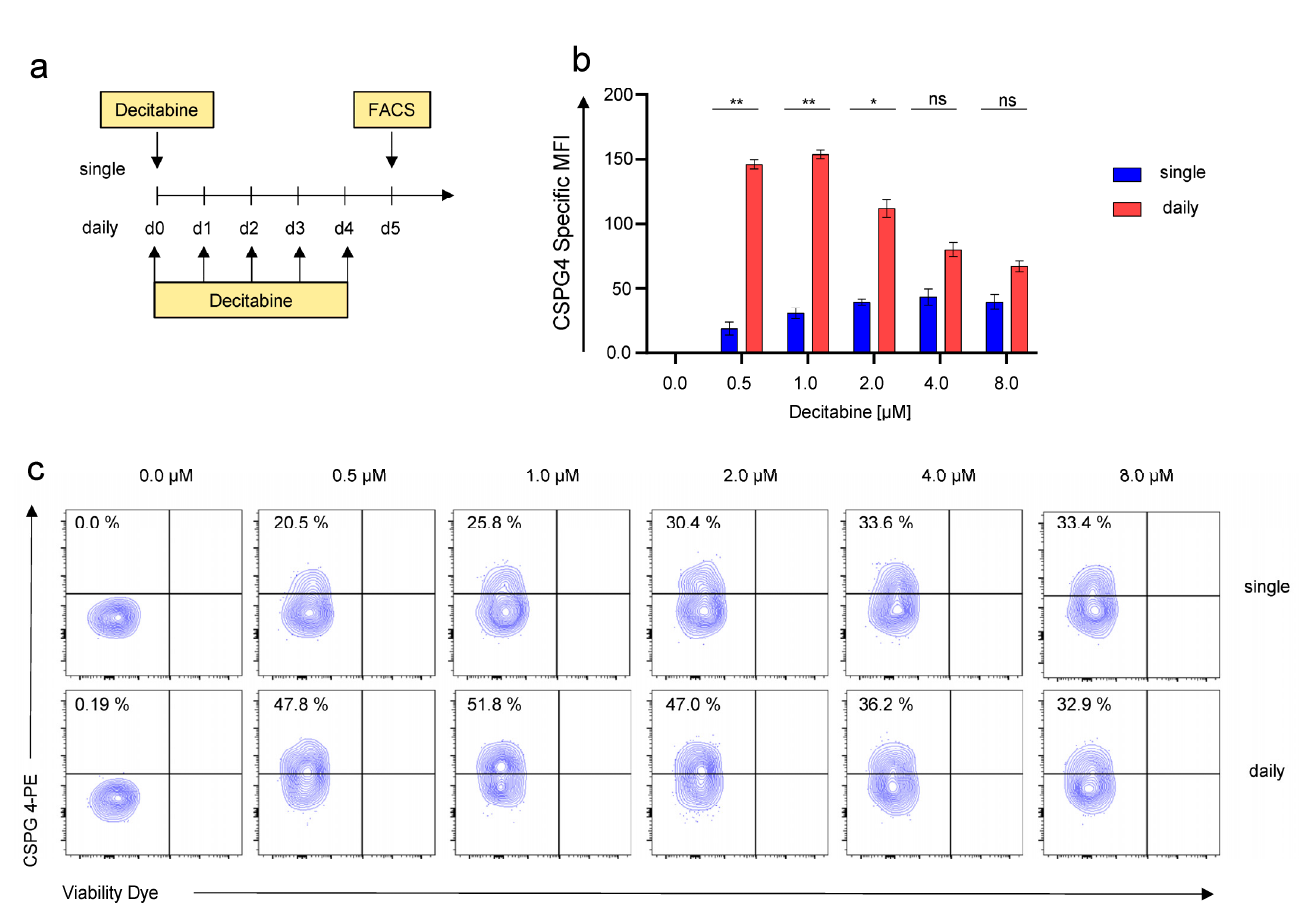
Figure 2. Daily application of decitabine results in greater CSPG4 induction in SKOV-3 ovarian cancer cells than single-shot application. ( a ) Schematic showing the experimental layout for the decitabine-mediated CSPG4 upregulation. SKOV-3 cells were either treated daily or once with decitabine at the indicated concentrations. For daily treatment, the culture medium was exchanged every day when adding the drug. CSPG4 upregulation was determined after 5 days. ( b ) Data represent geometric means ± SEM of three runs, p values were calculated by Student’s t -test, * indicates p ≤ 0.05, ** indicates p ≤ 0.01, and ns indicates not significant. ( c ) Contour plots of one representative run out of three independent experiments are depicted.